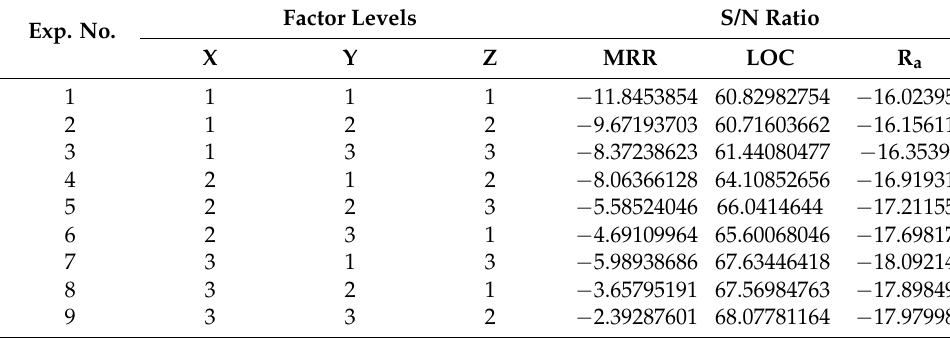
Table 6. S/N ratio for response parameters.